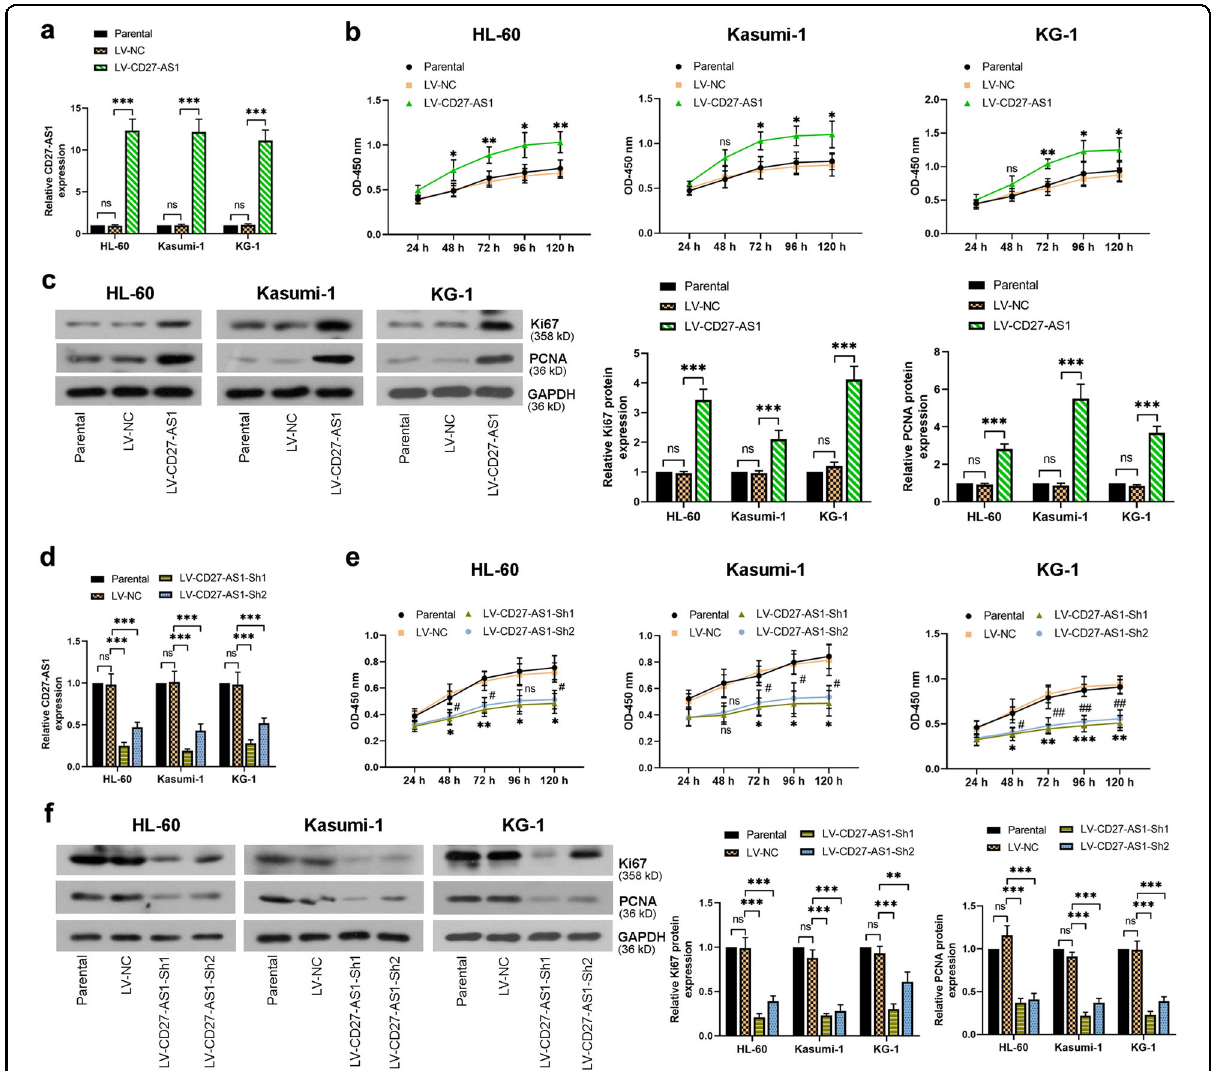
Fig. 2 CD27-AS1 promotes cell proliferation in the AML cell lines. Three AML cells (HL-60, Kasumi-1, and KG-1) were infected with LV-CD27-AS1. a qRT-PCR was performed to check the relative expression of CD27-AS1 after infection among three cell lines. b CCK-8 assay showed cell proliferation after LV-CD27-AS1 infection in AML cells. * P < 0.05, ** P < 0.01, ns = no signi fi cance versus the LV-NC. c Protein levels of Ki67 and PCNA in LV-CD27- AS1 infected AML cells were assessed using western blotting, and densitometry analysis was performed. Two LV-CD27-AS1-shRNAs were used to infect AML cells. d Relative expression of CD27-AS1 was assessed by qRT-PCR, after infection in HL-60, Kasumi-1, and KG-1 cells. e Cell proliferation was detected using CCK-8 assay. * P < 0.05, ** P < 0.01, *** P < 0.001, ns = no signi fi cance in LV-CD27-AS1-Sh1 versus the LV-NC; # P < 0.05, ## P < 0.01, ns = no signi fi cance in LV-CD27-AS1-Sh2 versus the LV-NC. f Western blotting was performed to check relative protein levels of Ki67 and PCNA after LV- CD27-AS1-shRNAs infection in three AML cell lines, with their quanti fi cation. N = 3. Data were shown as means ± SD. ** P < 0.01, *** P < 0.001 and ns = no signi fi